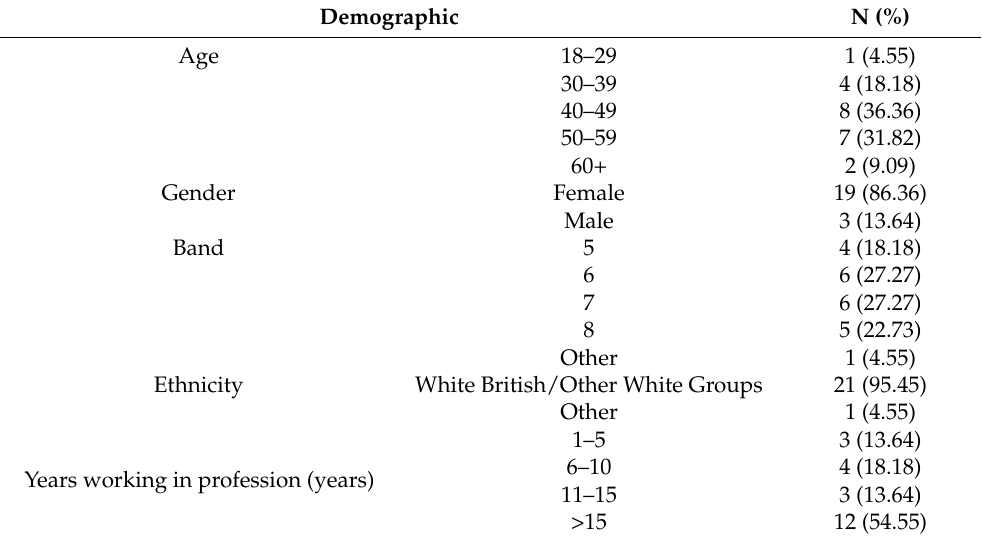
Table 1. Participant